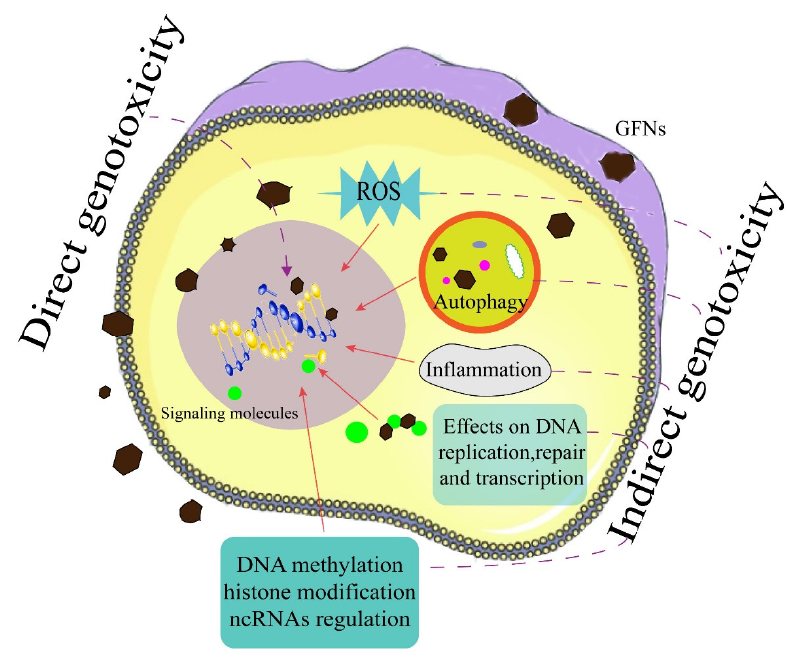
Figure 3. Direct and indirect effects of GFNs on DNA.